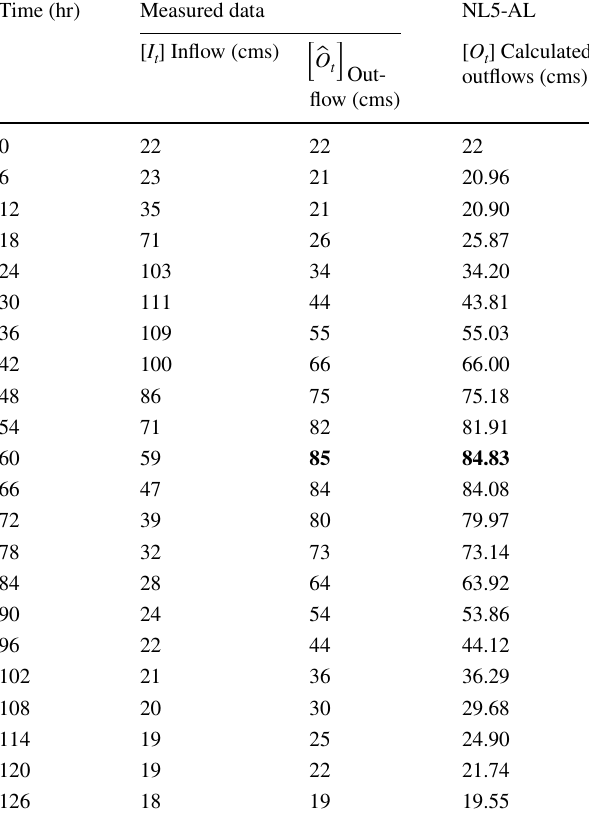
Table 1 Results related to Example 1 (Wilson flood data) Time (hr)